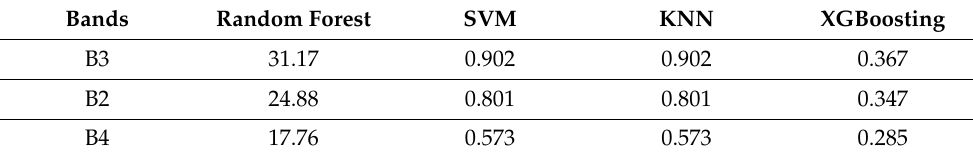
Table 6. Variable importance assessment.